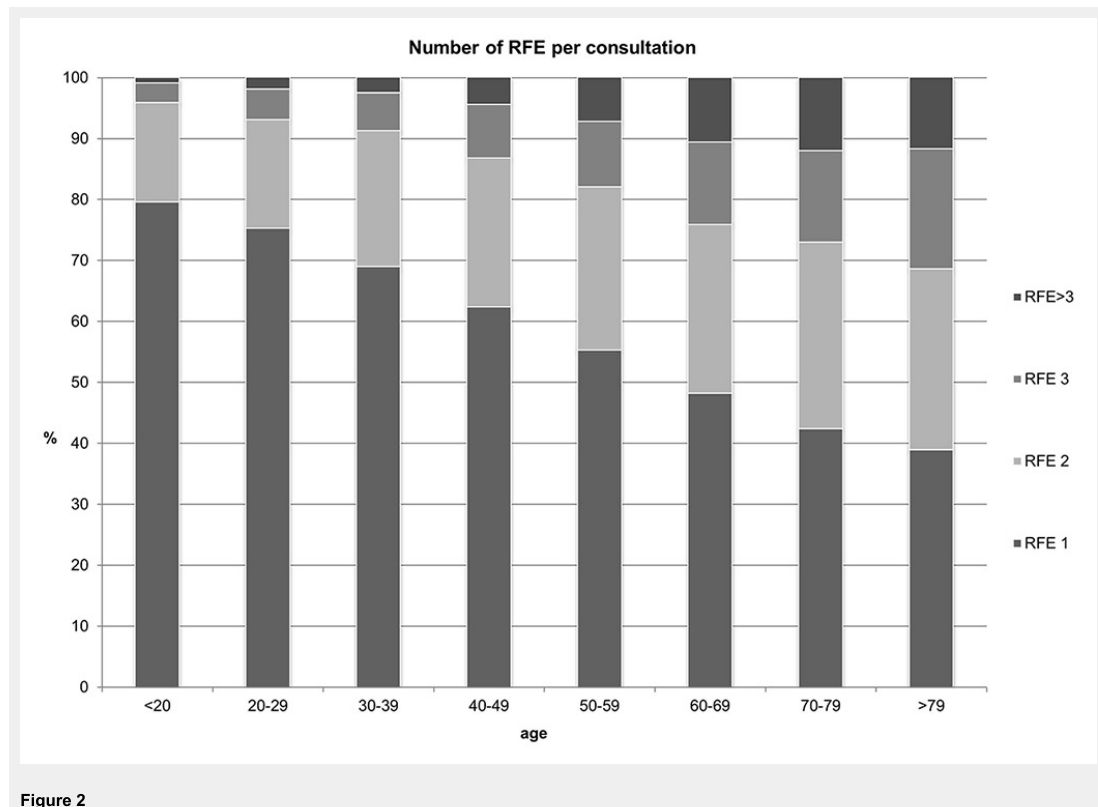
Number of RFE per consultation. Number of reasons for encounter (RFE), x-axis describes age of patients, y-axis describes percentages of each